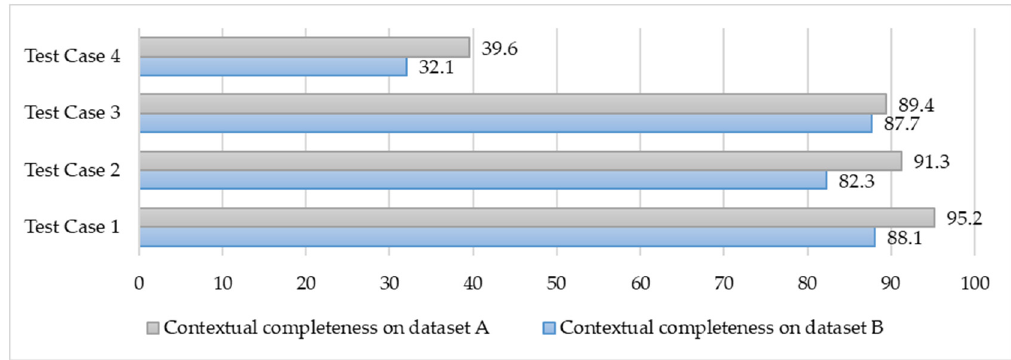
Figure 27. Completeness assessment of Teens’ Mood Care (TMC) application semantic data.